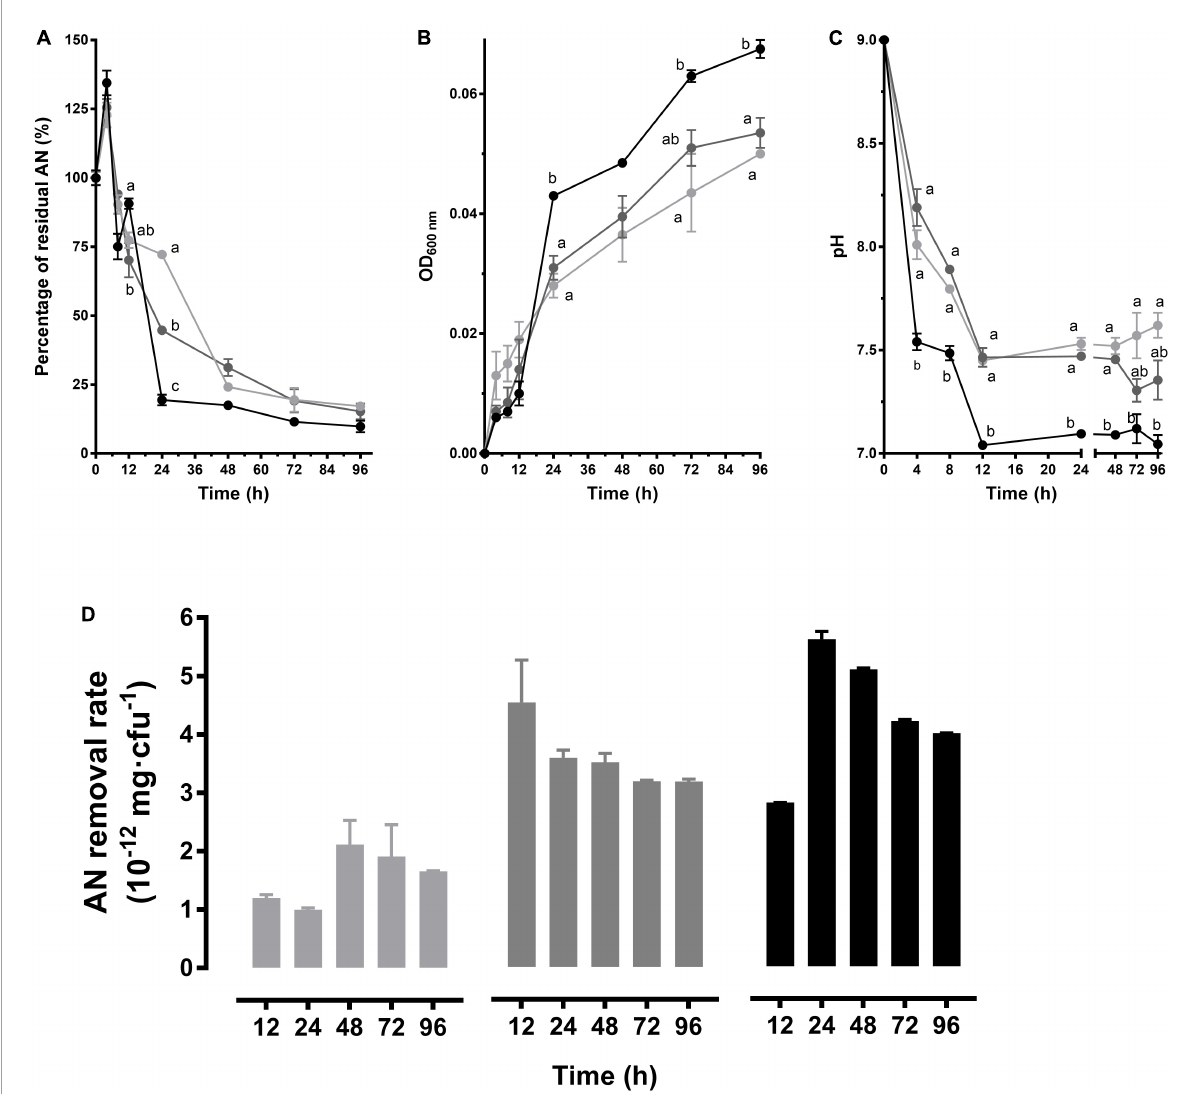
FIGURE3 AN removal characteristics of B. australimaris CT-WL5-10. The residual AN percentage (A) , OD 600 nm (B) , and pH (C) determined within 96 h were shown. Values of each time point with different superscripts in (A–C) were significantly different ( P < 0.05). (D) The removal rate (AN quantity per cell) in 0–12 h, 0–24 h, ... , 0–96 h of incubation. In (A–D) , lines or column in light gray, dark gray, and black color, respectively, represents 1, 2, and 3 mg/L initial AN concentration